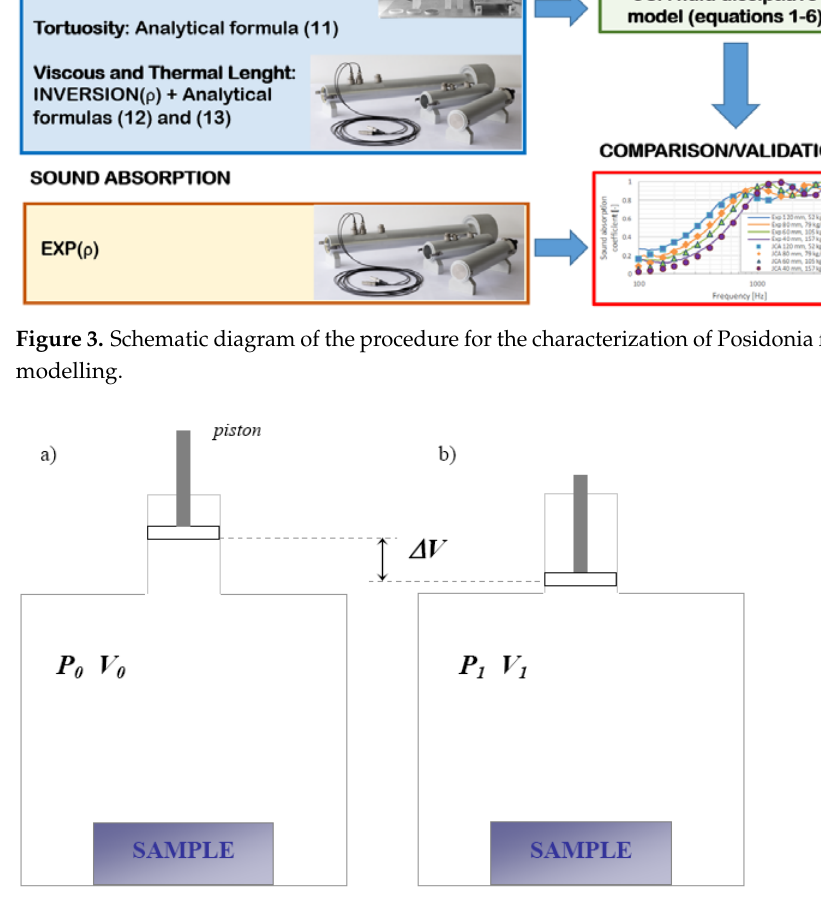
Figure 5. Porosity and tortuosity values as a function of the apparent density of the fibers, calculated with (9) and (11).